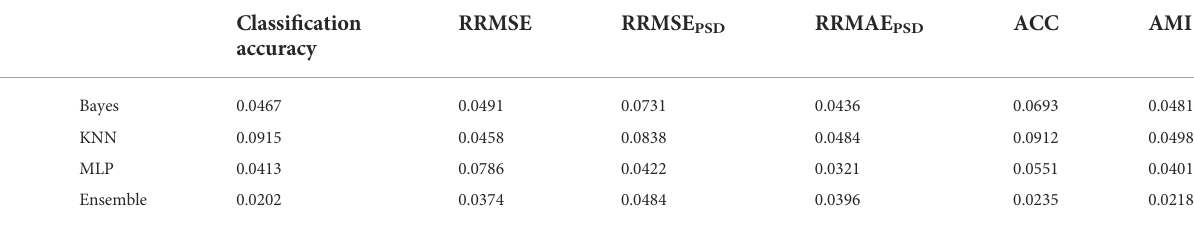
TABLE 7 Statistical analysis of the results in Figure 5 t-test analysis was conducted to check which criteria are signi fi cantly different. A con fi dence interval equal to 0.05 was considered in this analysis. p -values are reported in this table.